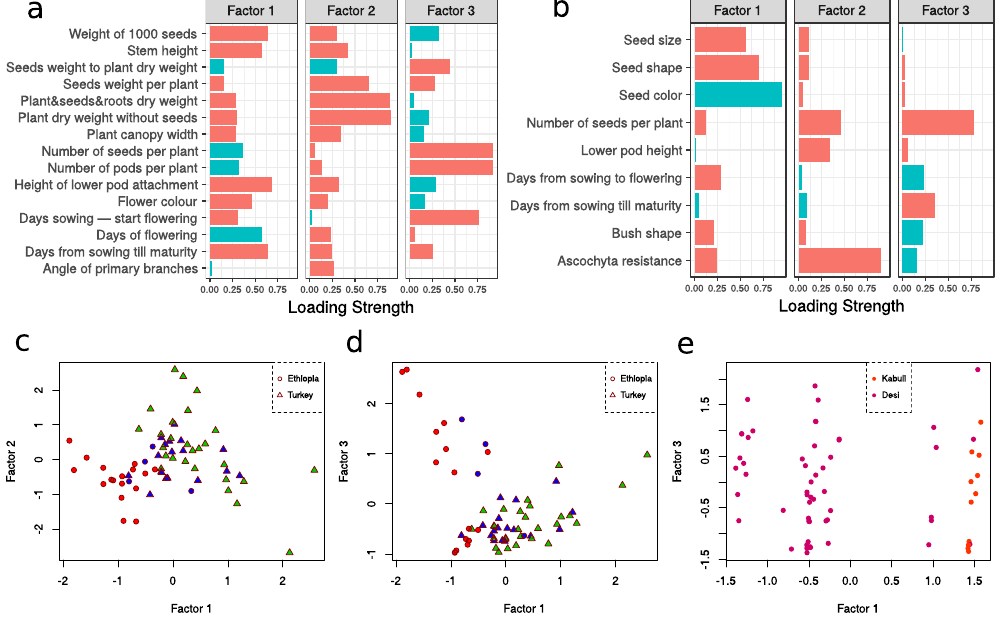
Figure 2. Factor analysis of phenotypic data reveal correlated traits. Factor loadings for Syrian field trial ( a ) and Astrakhan (Russian) field trial ( b ) phenotype data (red colour corresponds to positive loadings while turquoise colour to negative ones). ( c ) and ( d ): Factor 1 of Syrian phenotype data separates accessions according to colour scheme in all panels of Fig. 1. Green and red clusters are phenotypically distinct, while blue and green clusters partially overlap. As Factor 1 is driven by seed size and flower colour characteristics that differ between Desi and Kabuli varieties, it distinguishes market classes. ( e ) Factor 1 of Astrakhan phenotype data separates accessions largely based on seed characteristics that distinguish Kabuli and Desi